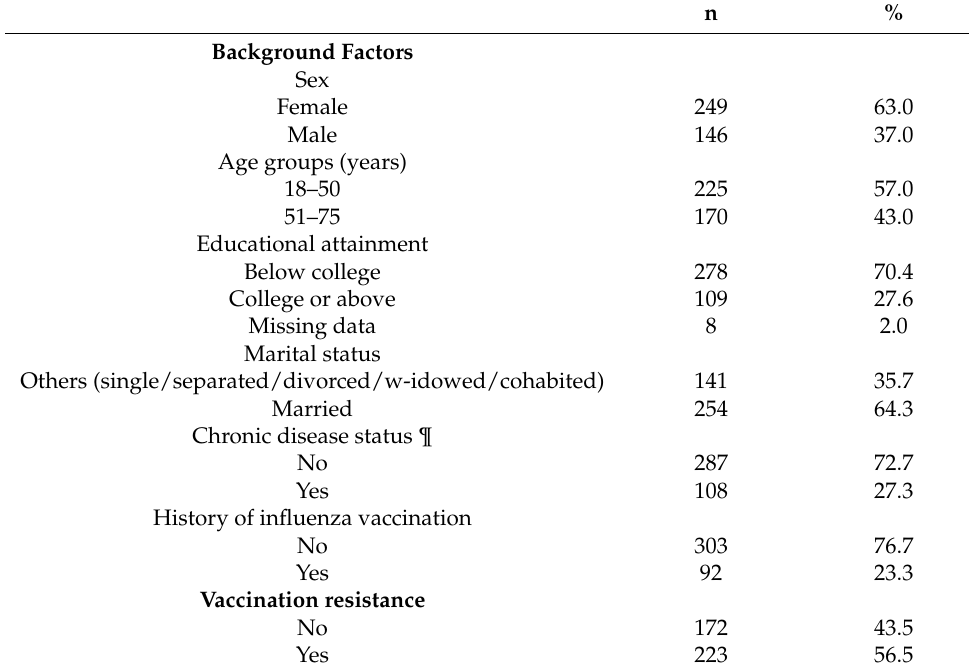
Table 1. Participants’ characteristics (n =